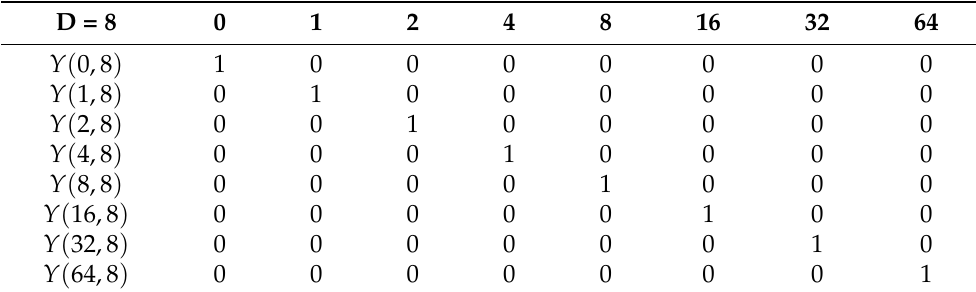
Table 1. All possible values encoded with method Y